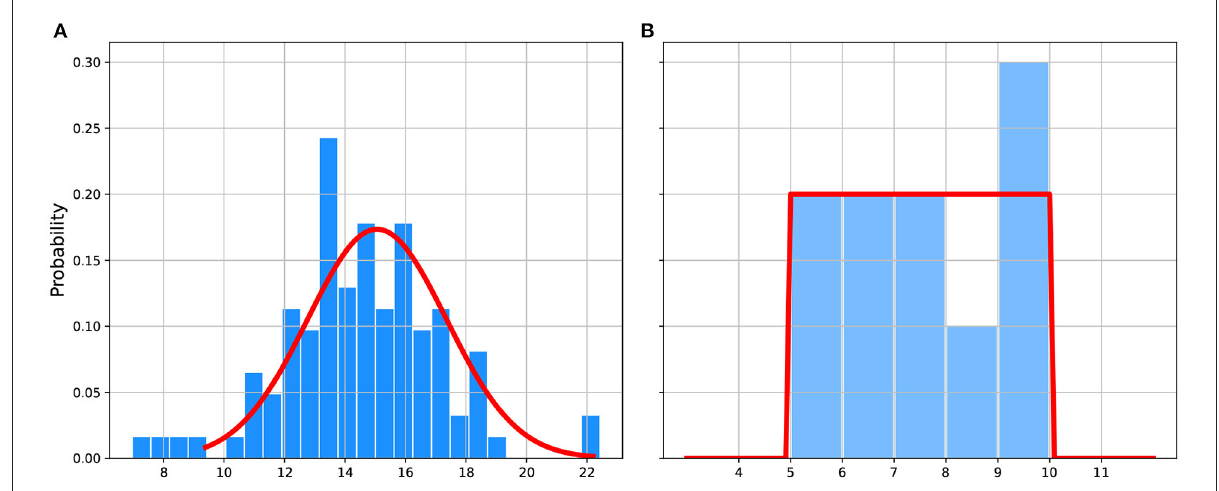
FIGURE2 (A) Example of the fitting of a Gaussian function to the outputs of an ensemble of climate models providing the heat index in the Balearic Islands. (B) Example of the fitting of a homogeneous pdf to the outputs of a poll to experts about the quality of information for tourists.